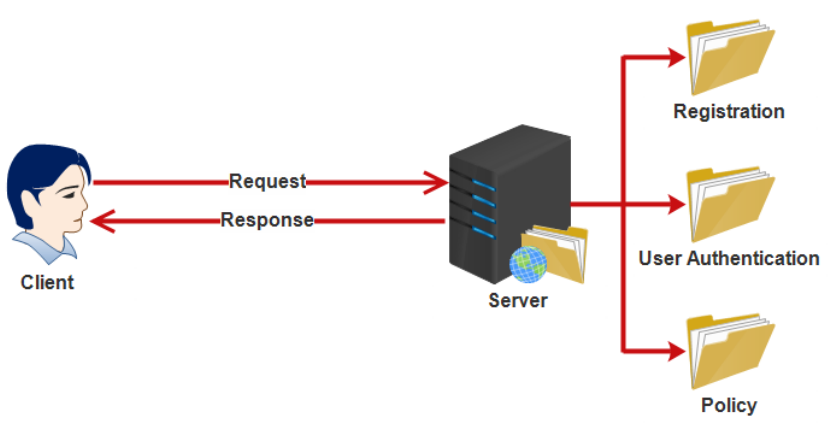
Figure 16. Identity based personal location system for